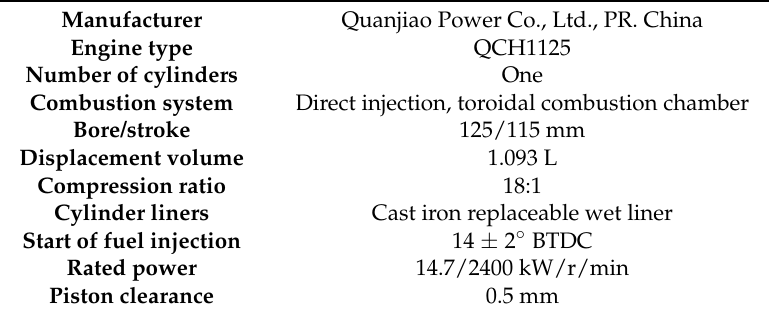
Figure 18. ( a ) Installation of acoustic emission (AE) sensor; ( b ) A photograph of the diesel engine test rig. Table 2. Specification of the test engine.